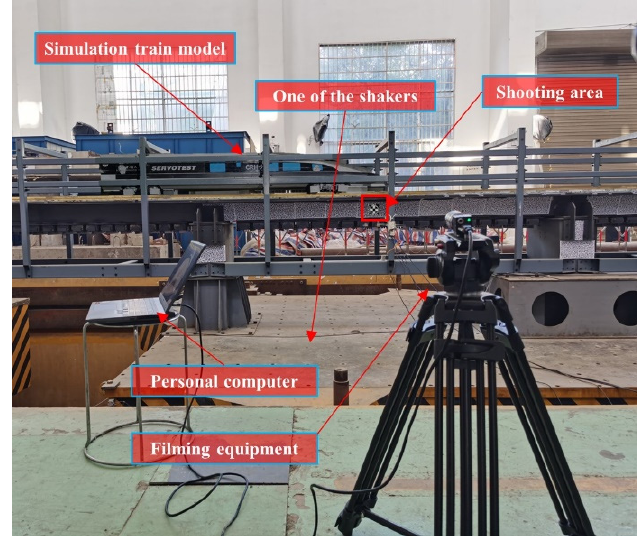
Figure 11. The experiment scene of indoor experiment.